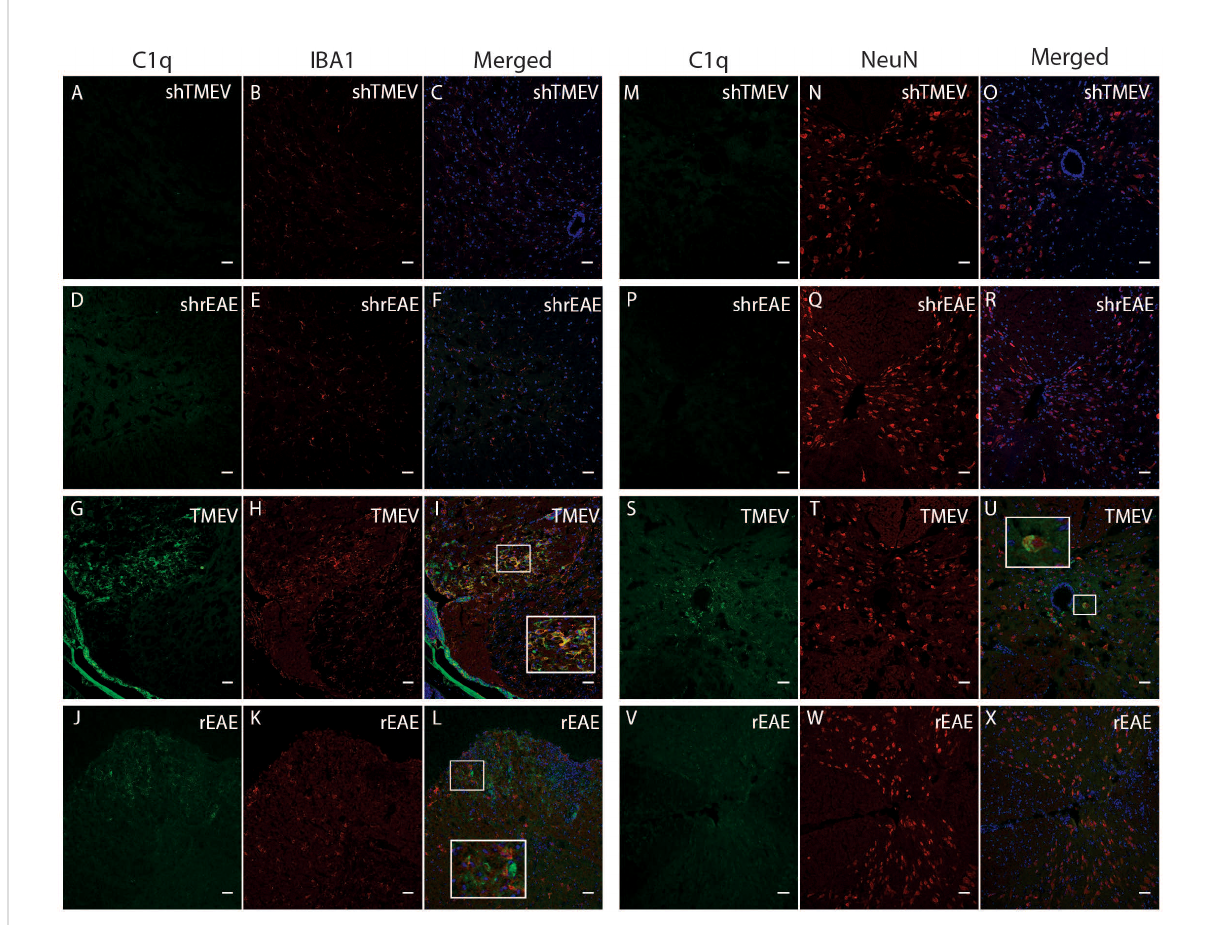
visualized in G, I, highlighting staining of extrinsic plasma C1q. In rEAE (L, X) , we found that C1q (green) does not colocalize with either Iba1 (Red in K) or NeuN (Red in W). Merge of C1q and Iba1 (C, F, I, L) and C1q and NeuN (O, R, U, X) is shown with DAPI (blue) for clarity of nucleus localization. Insets in images show white boxed areas at higher magni fi cation. Images are representative of 5 to 6 mice per group. Representative z stacks are shown and the scale bar = 100 m